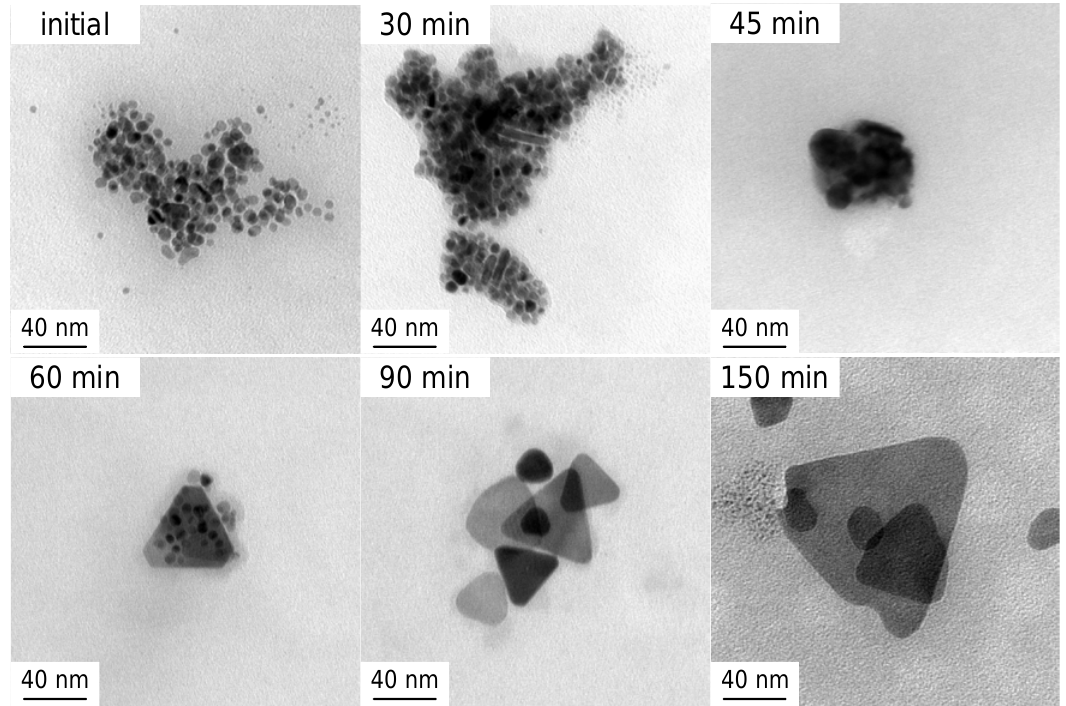
Figure 1. Examples of cryo-TEM images as a function of irradiation time. From left to right: Initial 0 min, 30 min, and 45 min (upper row) and 60 min, 90 min and 150 min irradiated solutions (lower row).